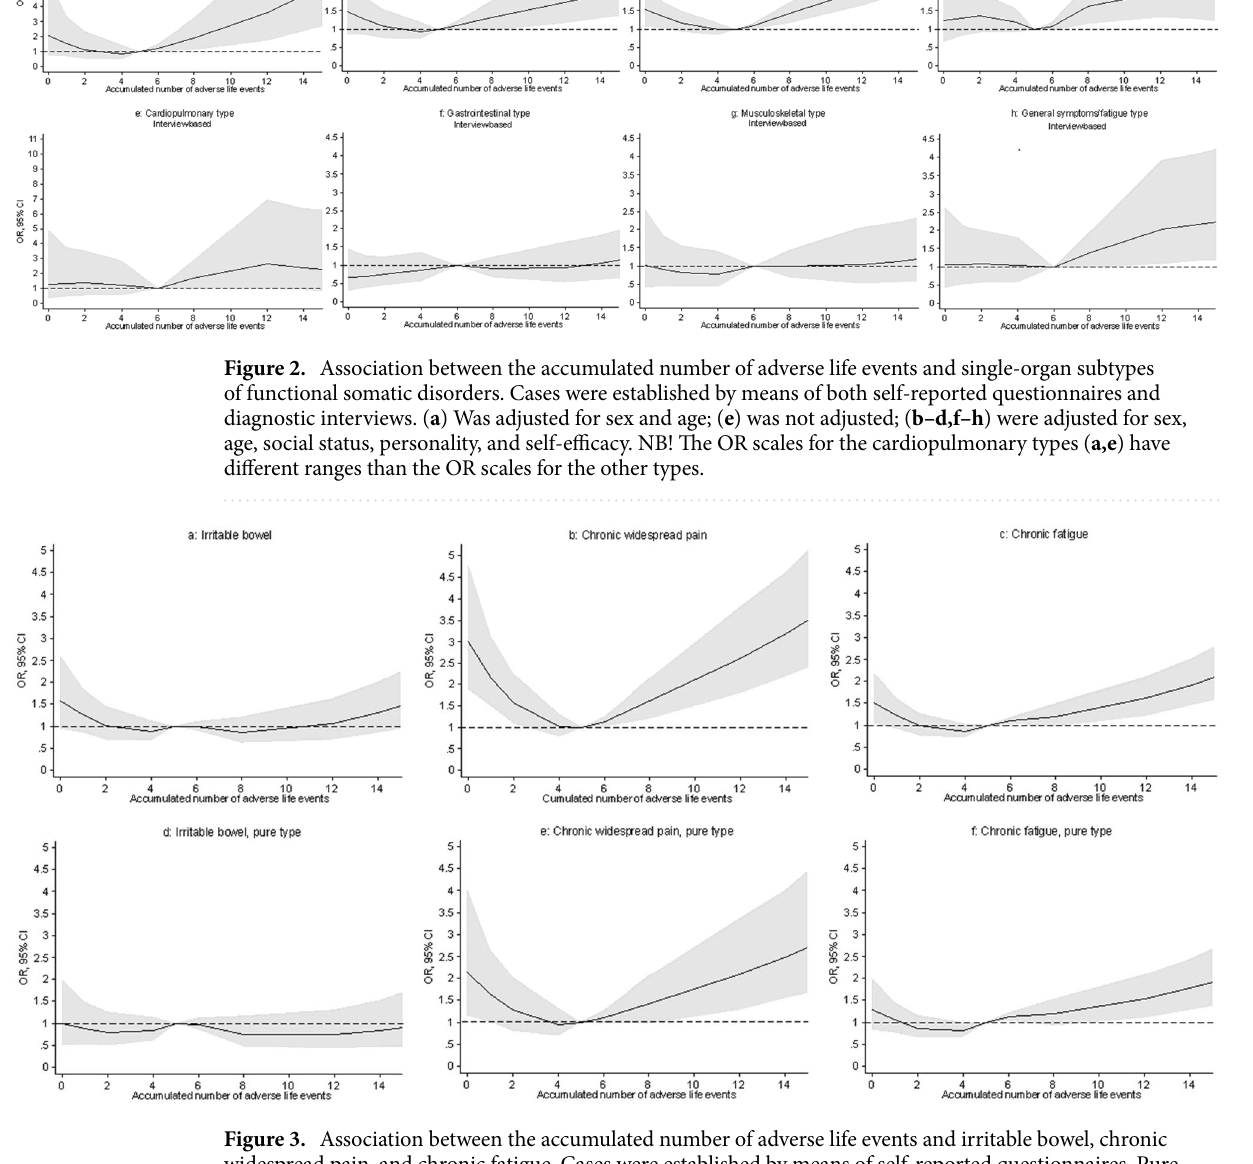
Figure 3. Association between the accumulated number of adverse life events and irritable bowel, chronic widespread pain, and chronic fatigue. Cases were established by means of self-reported questionnaires. Pure types constitute cases with only one syndrome, i.e. no comorbidity of one of the other syndromes. All analyses were adjusted for sex, age, personality traits, social status, and